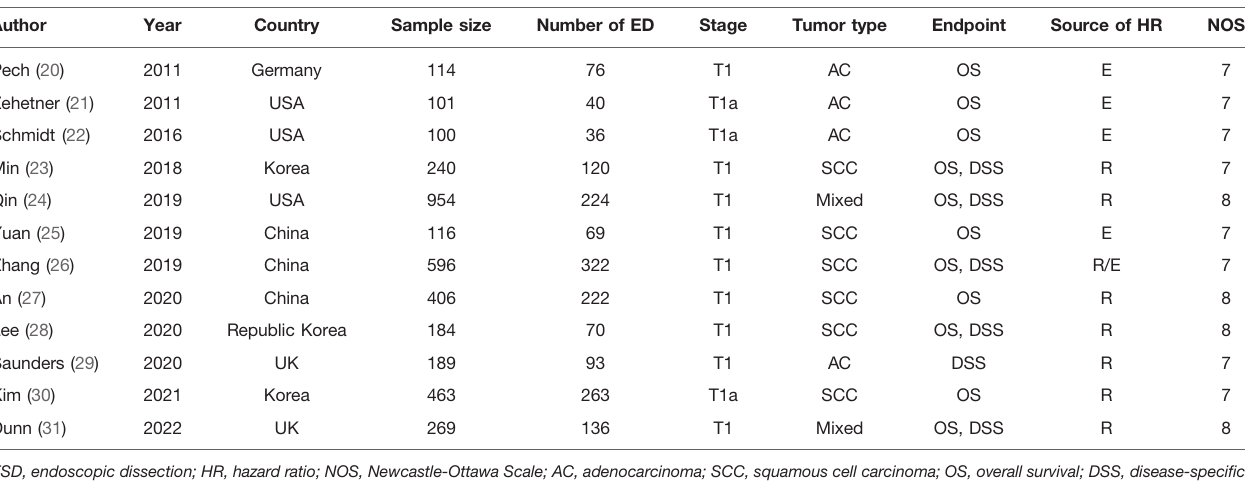
TABLE 1 | Basic characteristics of included studies.